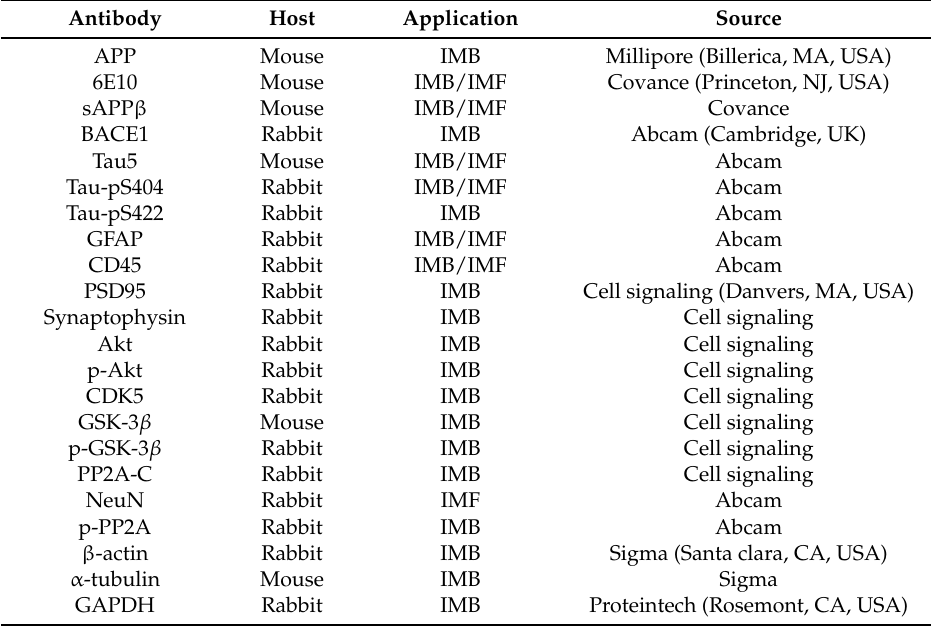
Table 1. Antibody